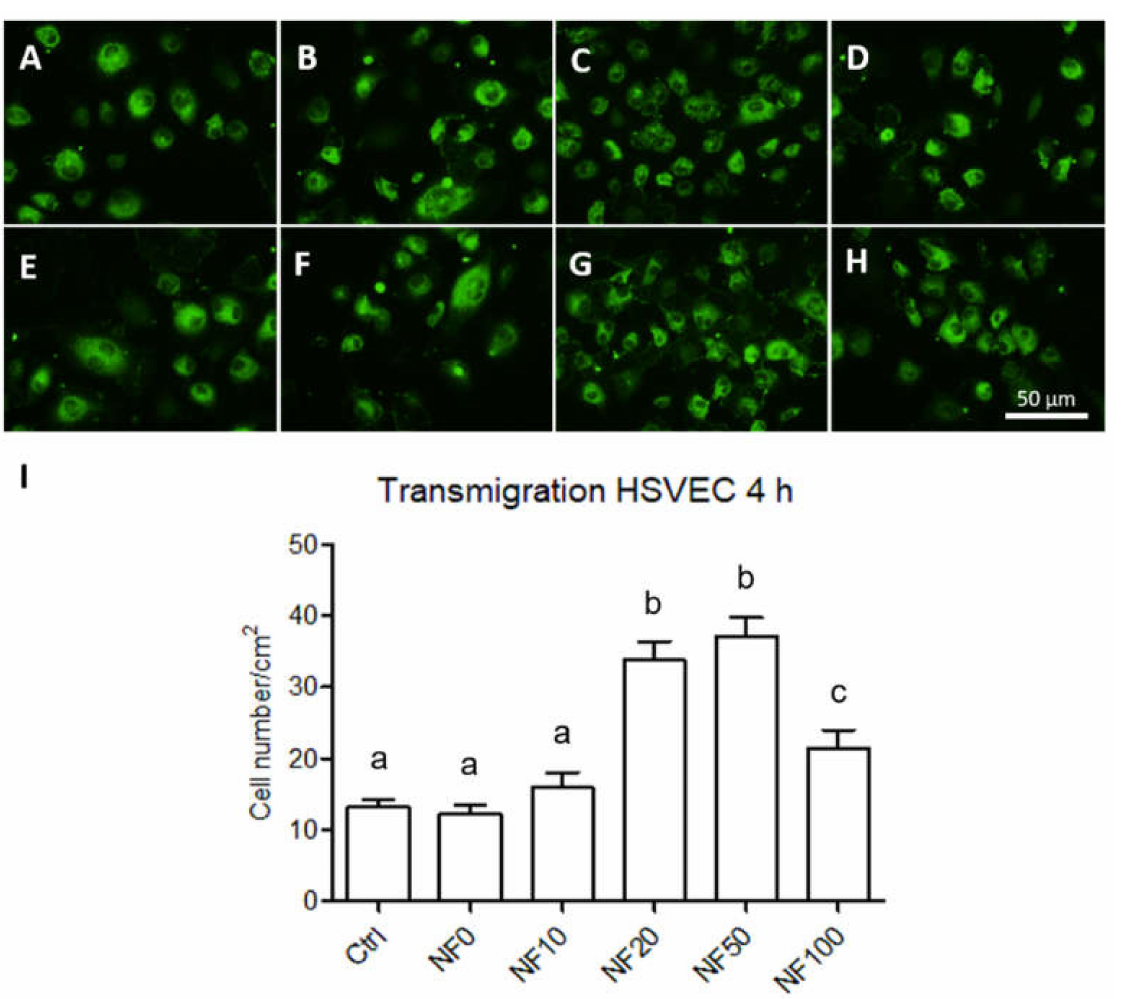
Figure 11. The maturation of the HSVECs in the monoculture and co-culture on day 7. The HSVECs monocultured in polystyrene wells with NF membranes floating in the medium ( A – D ) and co-cultured with HaCaT ( E – H ) grown on the membranes. In both cases, the following membranes were used: Ctrl ( A , E ), NF0 ( B , F ), NF20 ( C , G ) and NF50 ( D , H ). The cells were stained with immunofluorescence for the von Willebrand factor (green); Olympus IX71 microscope (Olympus, Tokyo, Japan), DP80 digital camera (Olympus, Tokyo, Japan), obj. × 20. The number of HSVECs that transmigrated through the inserts towards the medium with the Ctrl, NF10, NF20, NF50 and NF100 samples over 4 h ( I ). The differing superscripts above the columns denote significant differences between the samples that do not share the same superscript ( p <